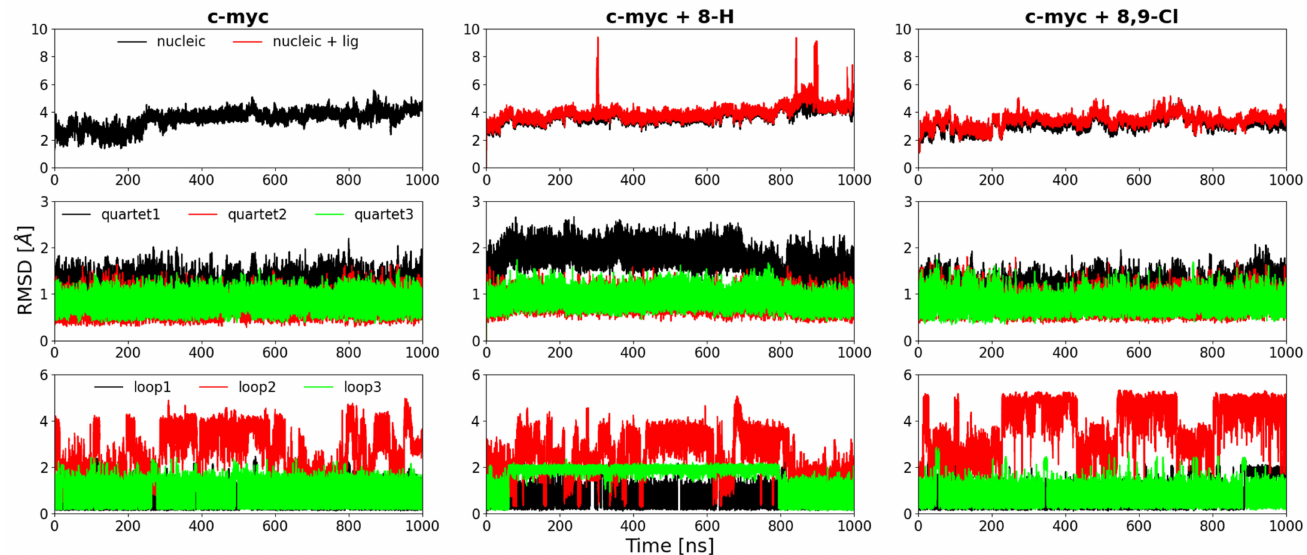
Figure 8. RMSD of the simulated systems at 350 K (NPT). Each column refers to a different system: (left column) c-myc without ligand, (central column) c-myc + ligand 8-H, and (right column) c-myc + ligand 8,9-di-Cl. Each row represents a different set of heavy atoms selected for the RMSD calculation. First row: in black all DNA residues, in red all residues + ligand. Second row: black, red, and green are the first, the second, and the third loop, respectively. Third row: black, red, and green are the first, the second, and the third quartet, respectively. Each simulation is 1000 nanosecond (ns)